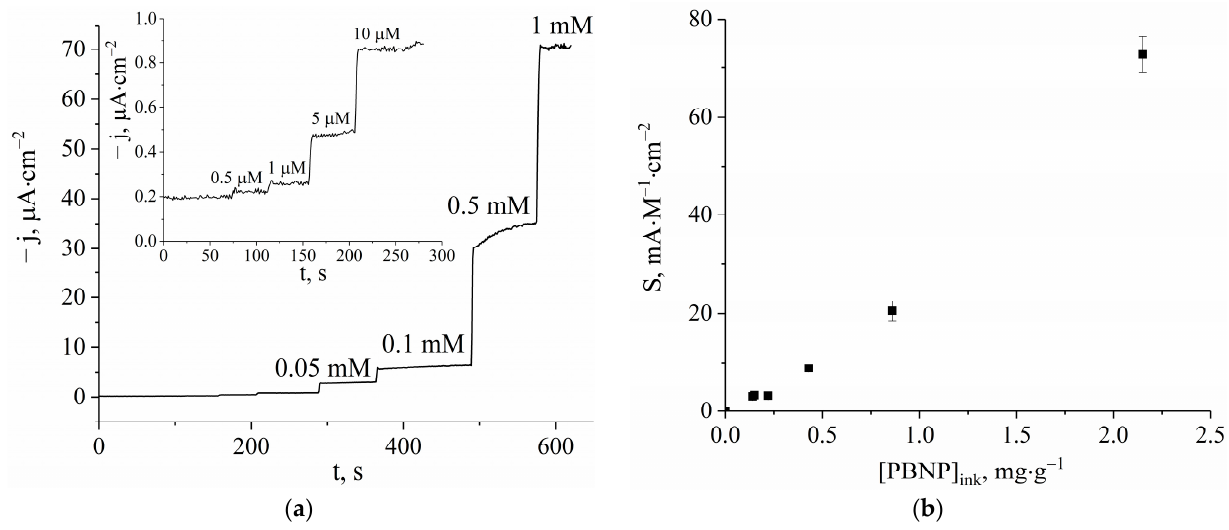
Figure 4. ( a ) The calibration curve for the printed hydrogen peroxide sensor with 2.15 mg/g of PBNPs in carbon/graphite ink; ( b ) sensitivity dependance on Prussian blue nanoparticle concentra- tion in carbon/graphite ink. carbon/graphite